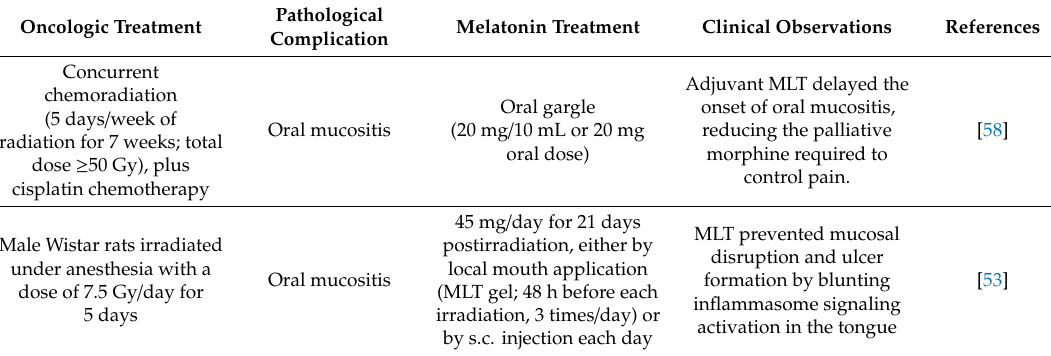
Table 2. Adjuvant use of melatonin in ameliorating radio / chemotherapy side-e ff ects. Oncologic